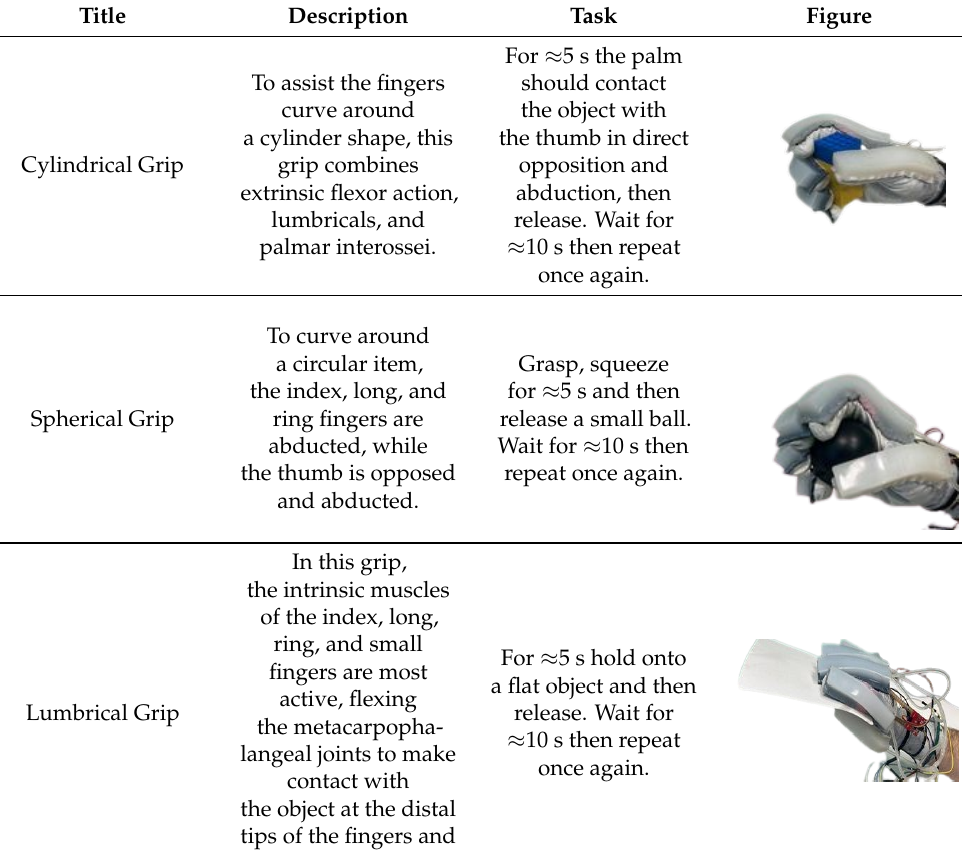
Table 2. Validation experiment—hand function